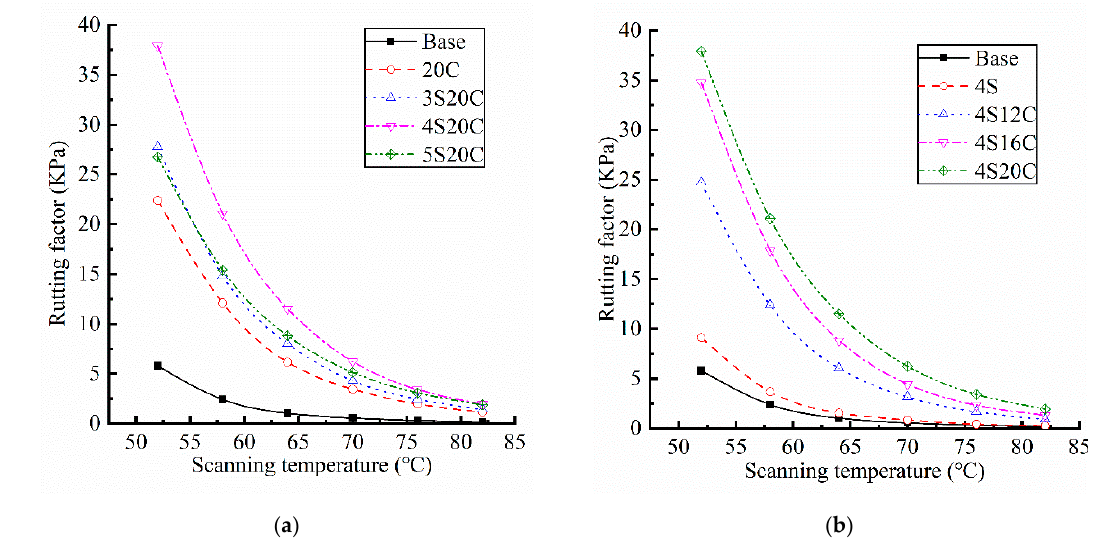
Figure 4. Rutting factors of asphalt: ( a ) with different nano-SiO 2 content, and ( b ) with different rubber powder content.